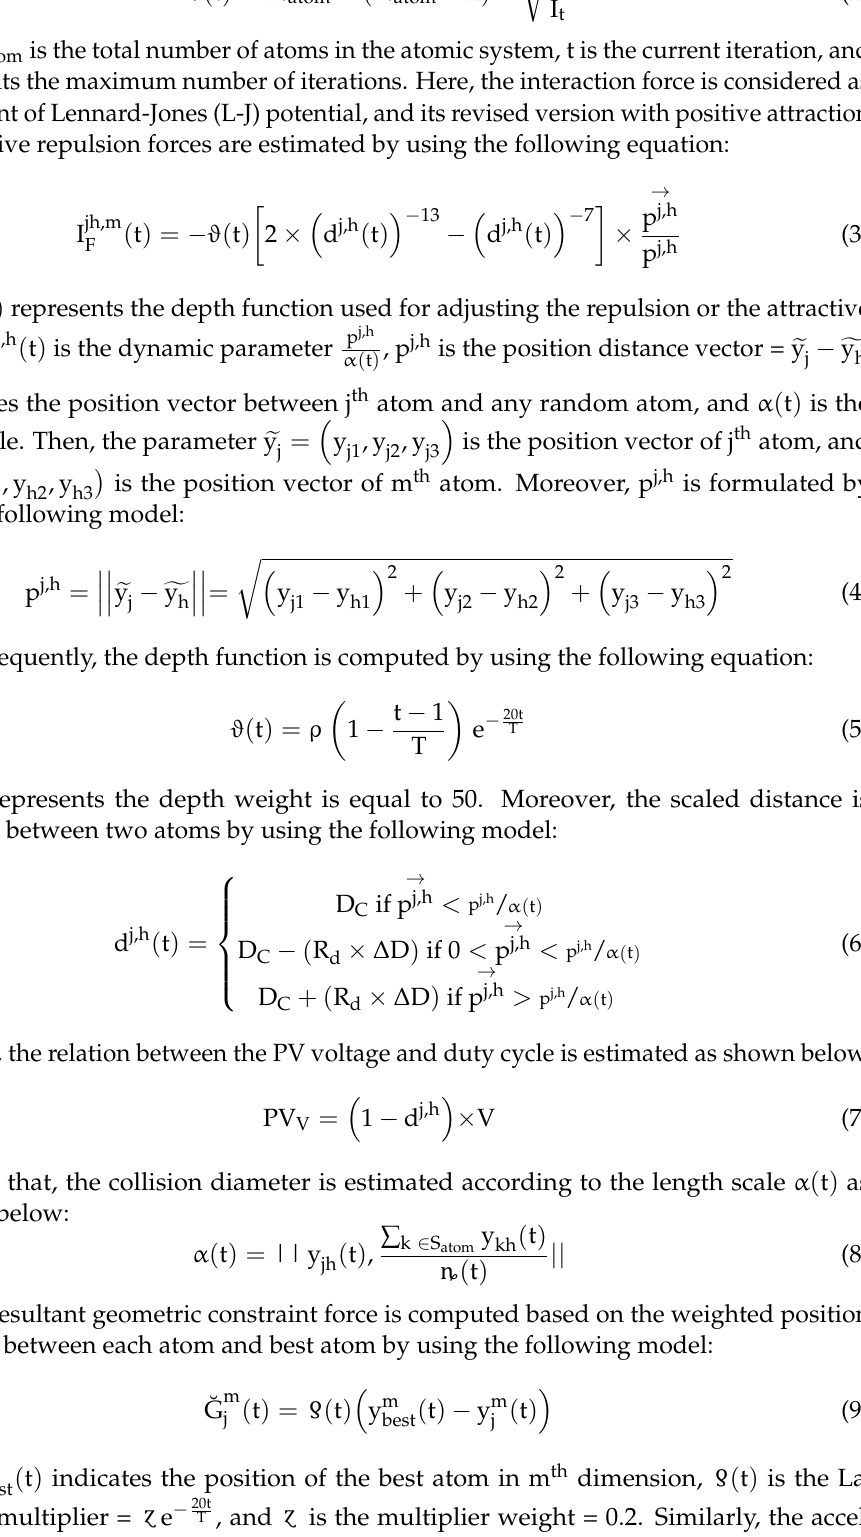
6 of 33 Figure 3. Flow of the ASO algorithm. In this technique, the duty cycle, PV cell temperature, and solar irradiance are initial- ized as the inputs, and the best optimal solution is produced as the output that helps to